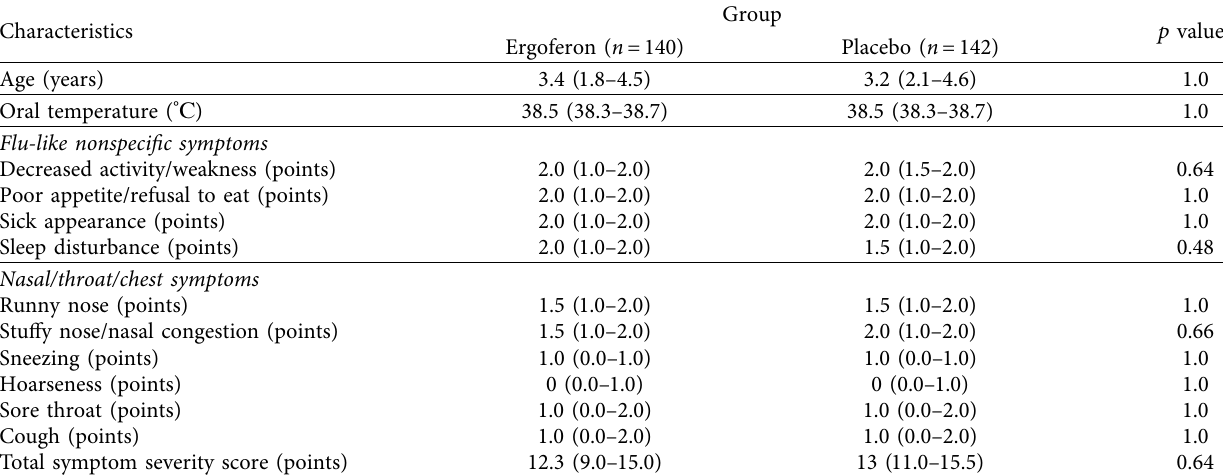
Table 1: Baseline characteristics of the patients.